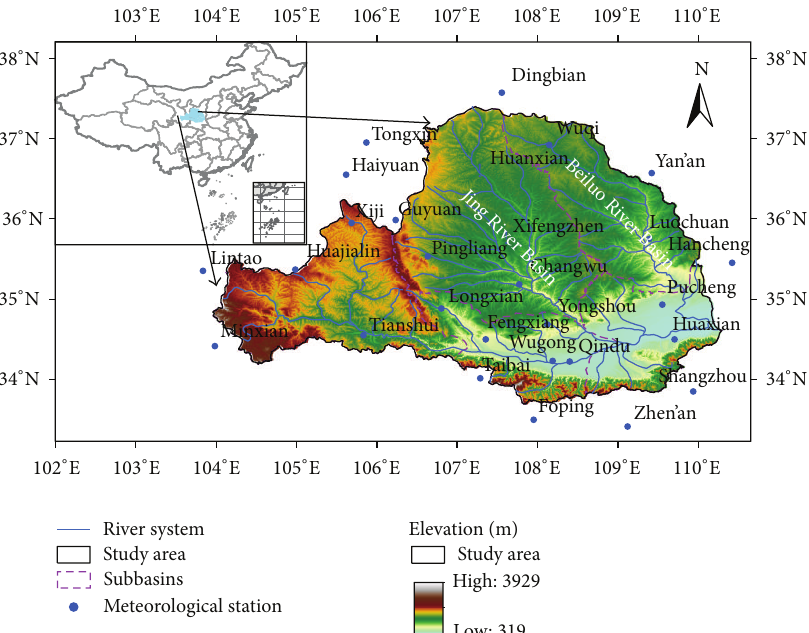
Figure 1: Location of the Wei River Basin. The black lines represent the boundary of the study area, and the blue dots denote the used meteorological stations.